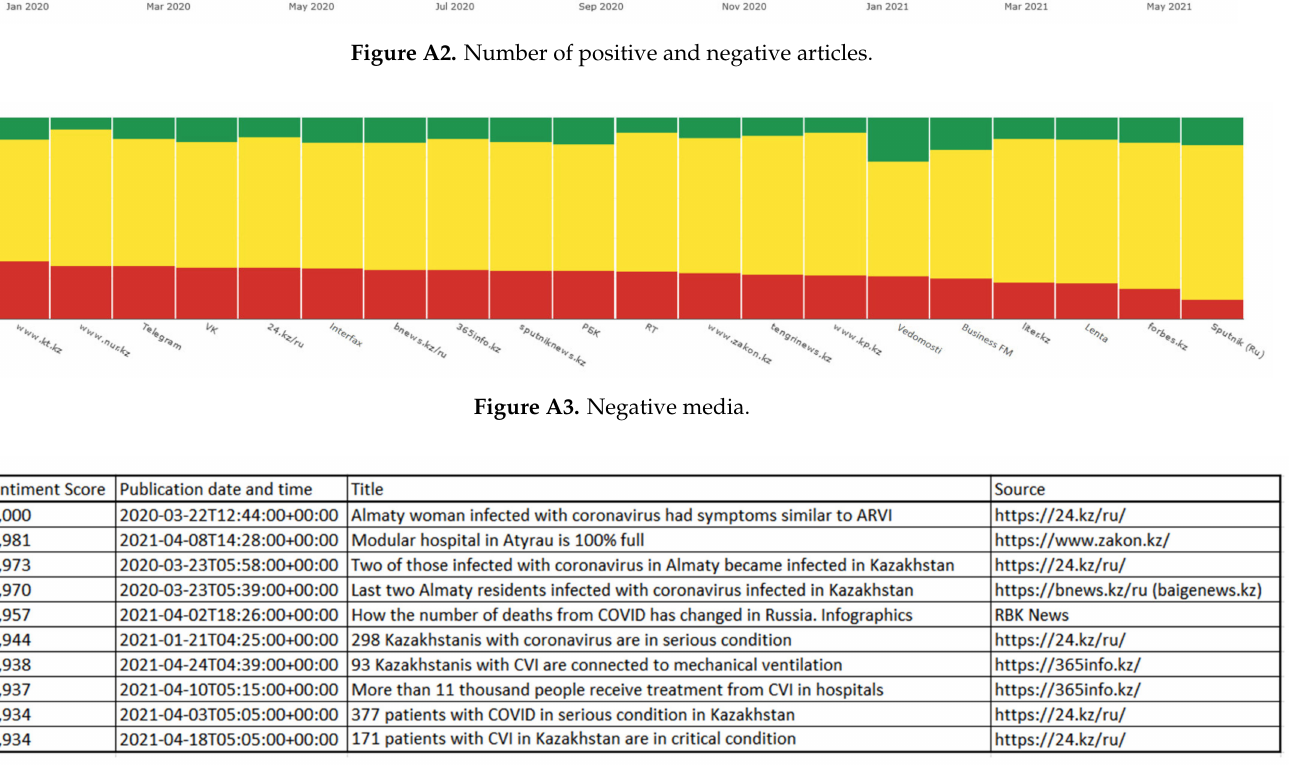
Figure A4. Top negative news.